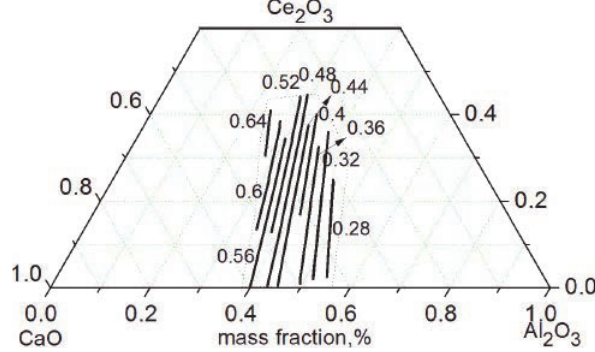
Fig. 5: The iso-mass action concentration curves of CaO in